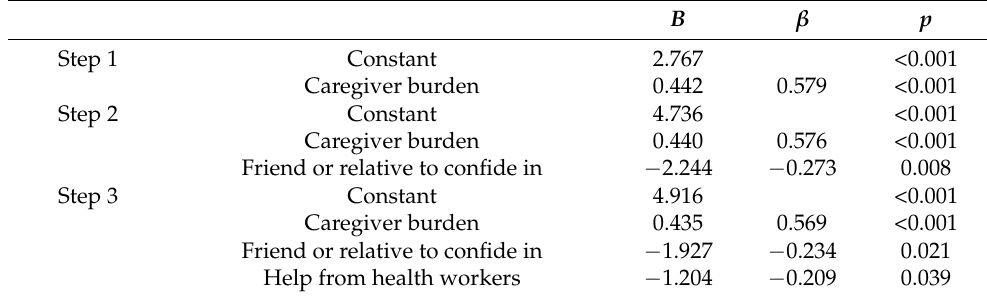
Table 6. Forward regression analysis for factors associated with psychological distress (GHQ-12).